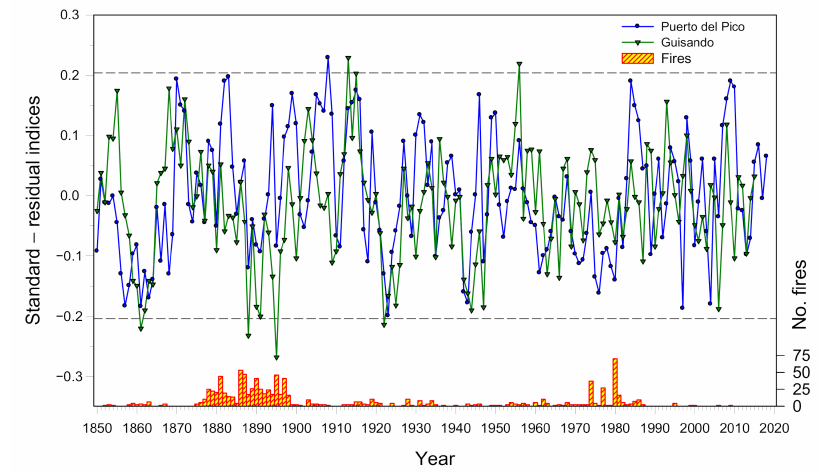
Figure 5. Differences between the standard and residual indices of the two Scots pine sites (Puerto del Pico, Guisando; lines with symbols) for the period 1850–2018 and annual frequency of fires according to archive sources (bars, right y-axis). The dashed lines show the mean of standard minus residual indices ± 2.96 times the standard deviation indicating the 95% confidence